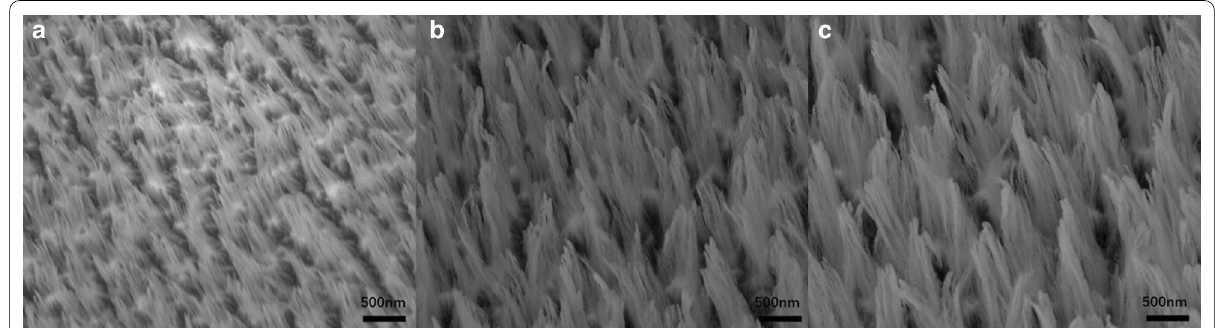
Fig. 1 SEM images of GaAs substrate under different etching